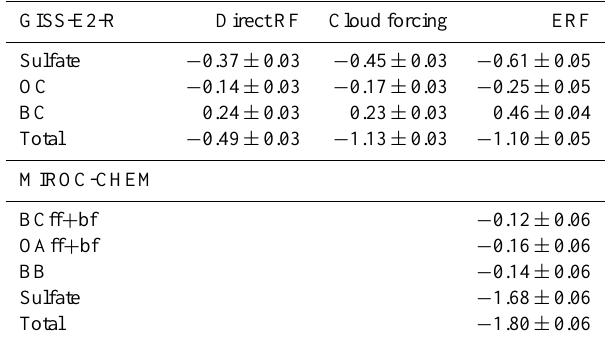
Table E1. Direct RF, cloud forcing and ERF caused by individual aerosol components and all aerosols in the GISS-E2-R and MIROC- CHEM models (Wm − 2 )